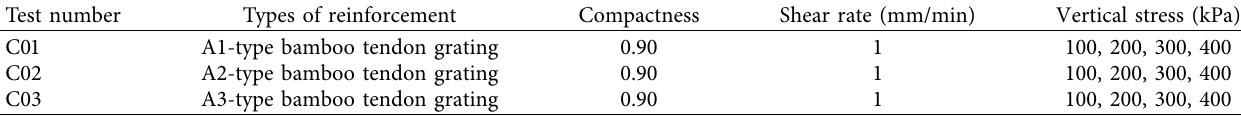
Table 8: Test schemes for bamboo tendon grating with different spacings.